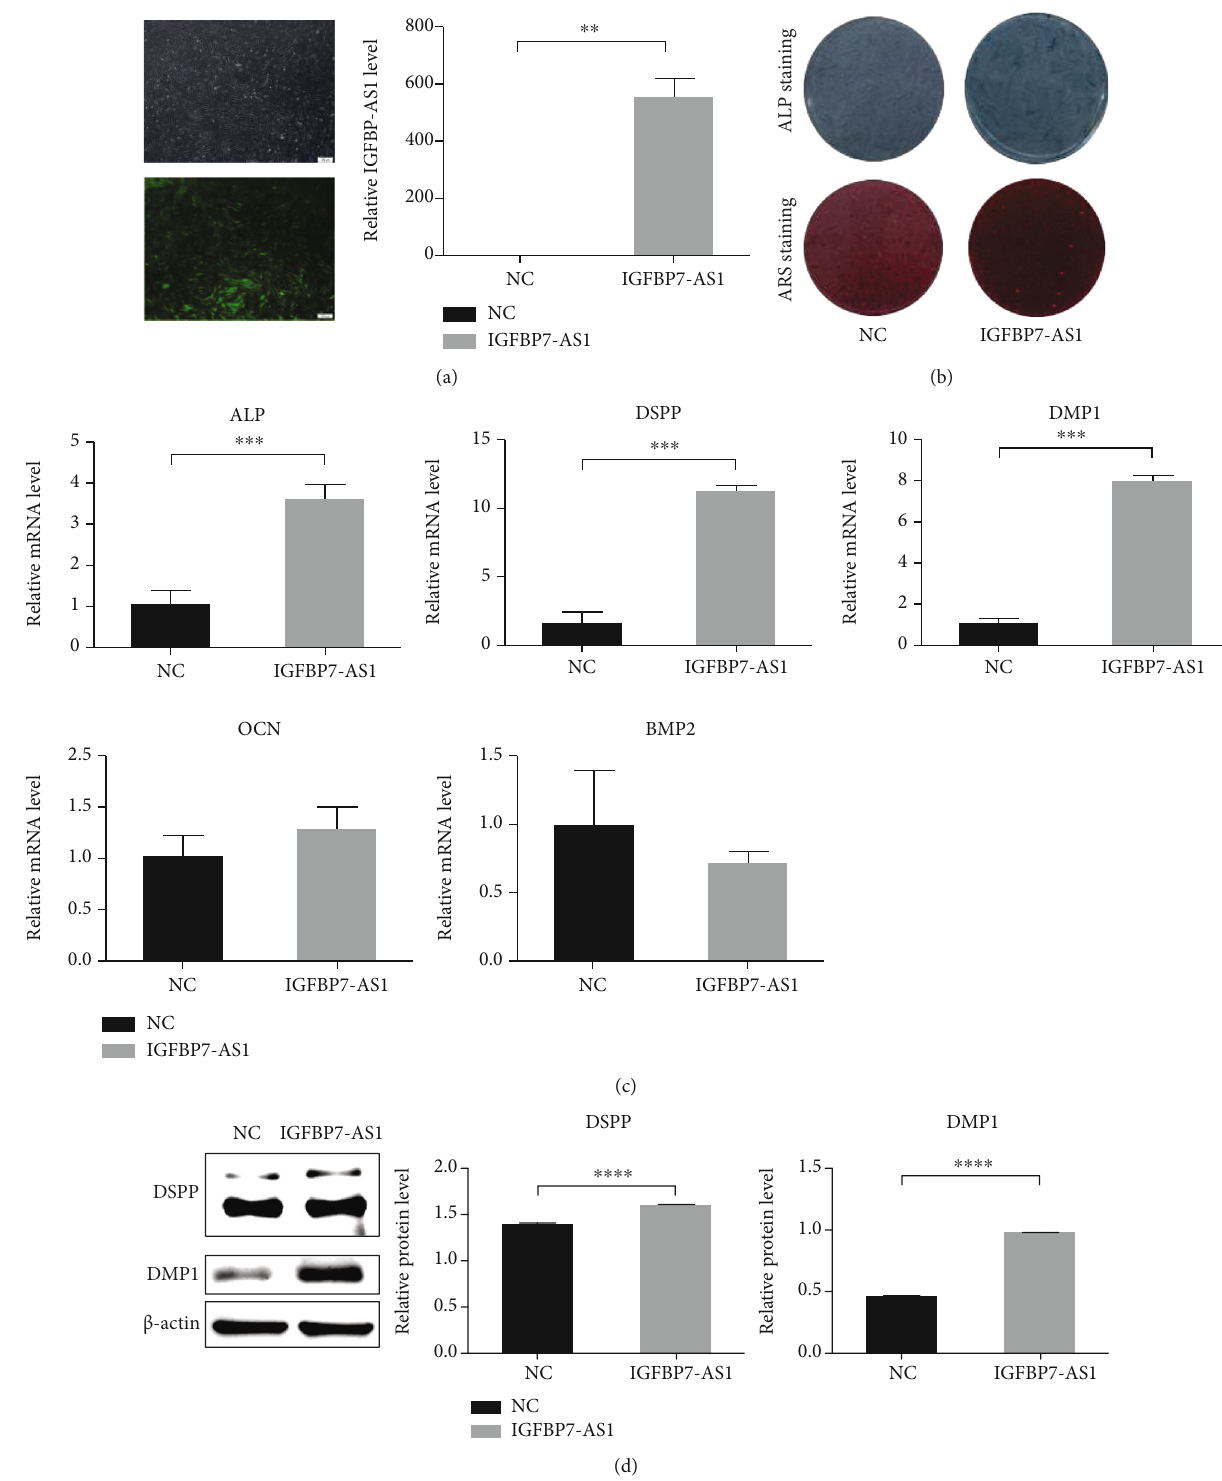
Figure 4: IGFBP7-AS1 overexpression increases the odontogenic di ff erentiation of SHED. (a) Fluorescence microscope and qRT-PCR detected the transfection e ff ect of IGFBP7-AS1 overexpression lentiviruses in the NC and IGFBP7-AS1 groups. Scale bar = 100 μ m . (b) Images of ALP staining of SHED on day 7 after odontogenic di ff erentiation and ARS staining of SHED on day 14 after odontogenic di ff erentiation in the NC and IGFBP7-AS1 groups. (c) qRT-PCR detected osteo/odontogenic di ff erentiation-related markers: ALP, DSPP, DMP1, OCN, and BMP2 in the NC and IGFBP7-AS1 groups. (d) Western blot detected odontogenic di ff erentiation-speci fi c markers: DSPP and DMP1 in the NC and IGFBP7-AS1 groups. Data were expressed as the mean ± standard deviation (SD) of three experiments per group, ∗∗ p < 0 : 01 , ∗∗∗ p < 0 : 001 , and ∗∗∗∗ p < 0 : 0001